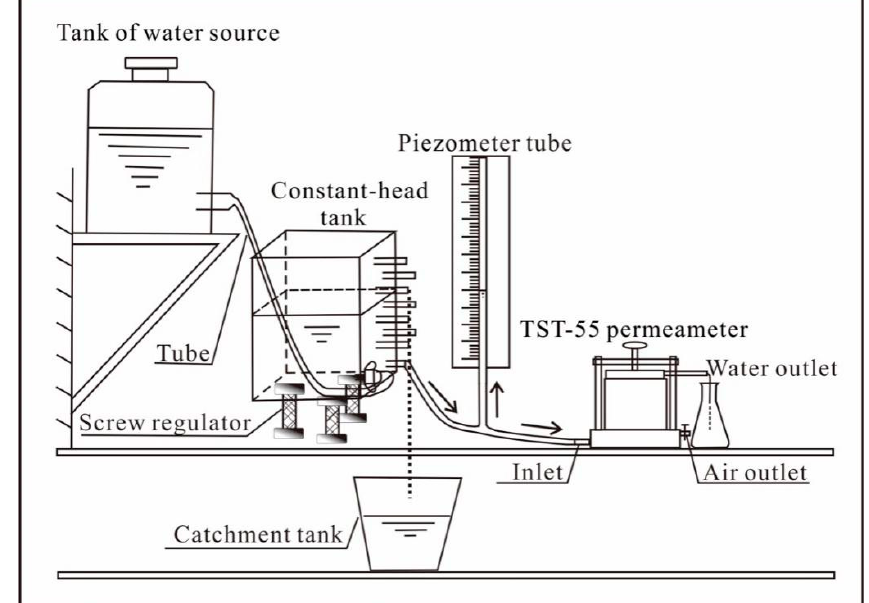
Figure 3. Saturated permeability test apparatus.